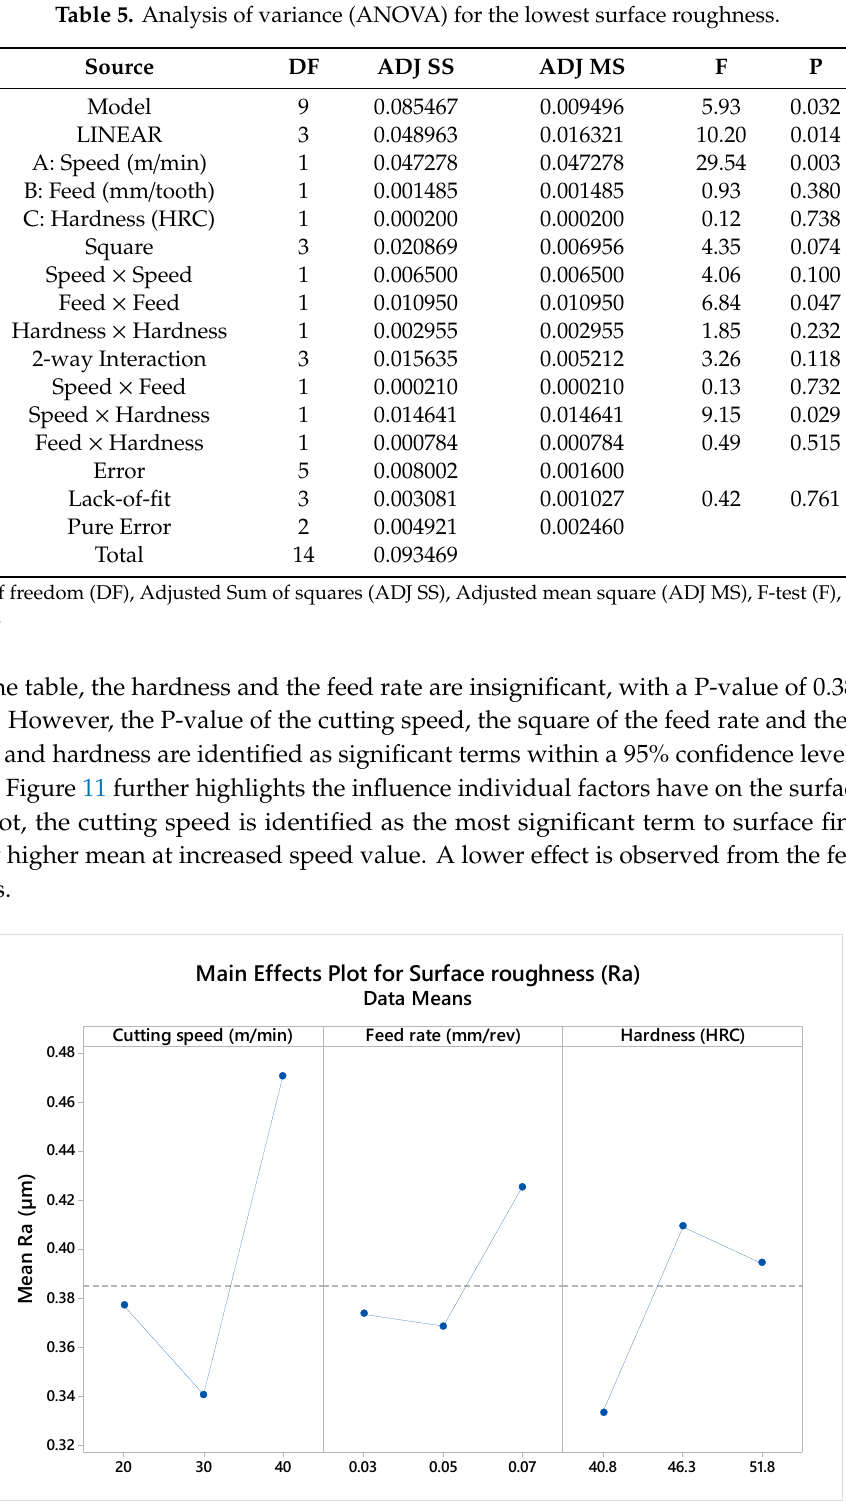
Table 5. Analysis of variance (ANOVA) for the lowest surface roughness.